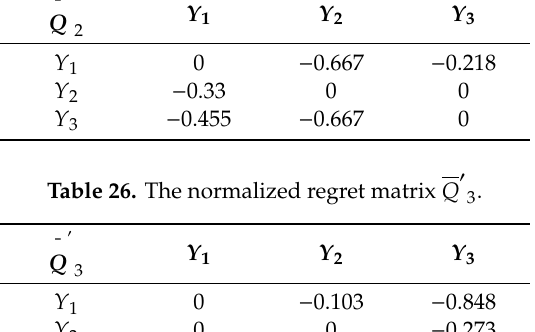
Table 25. The normalized regret matrix Q